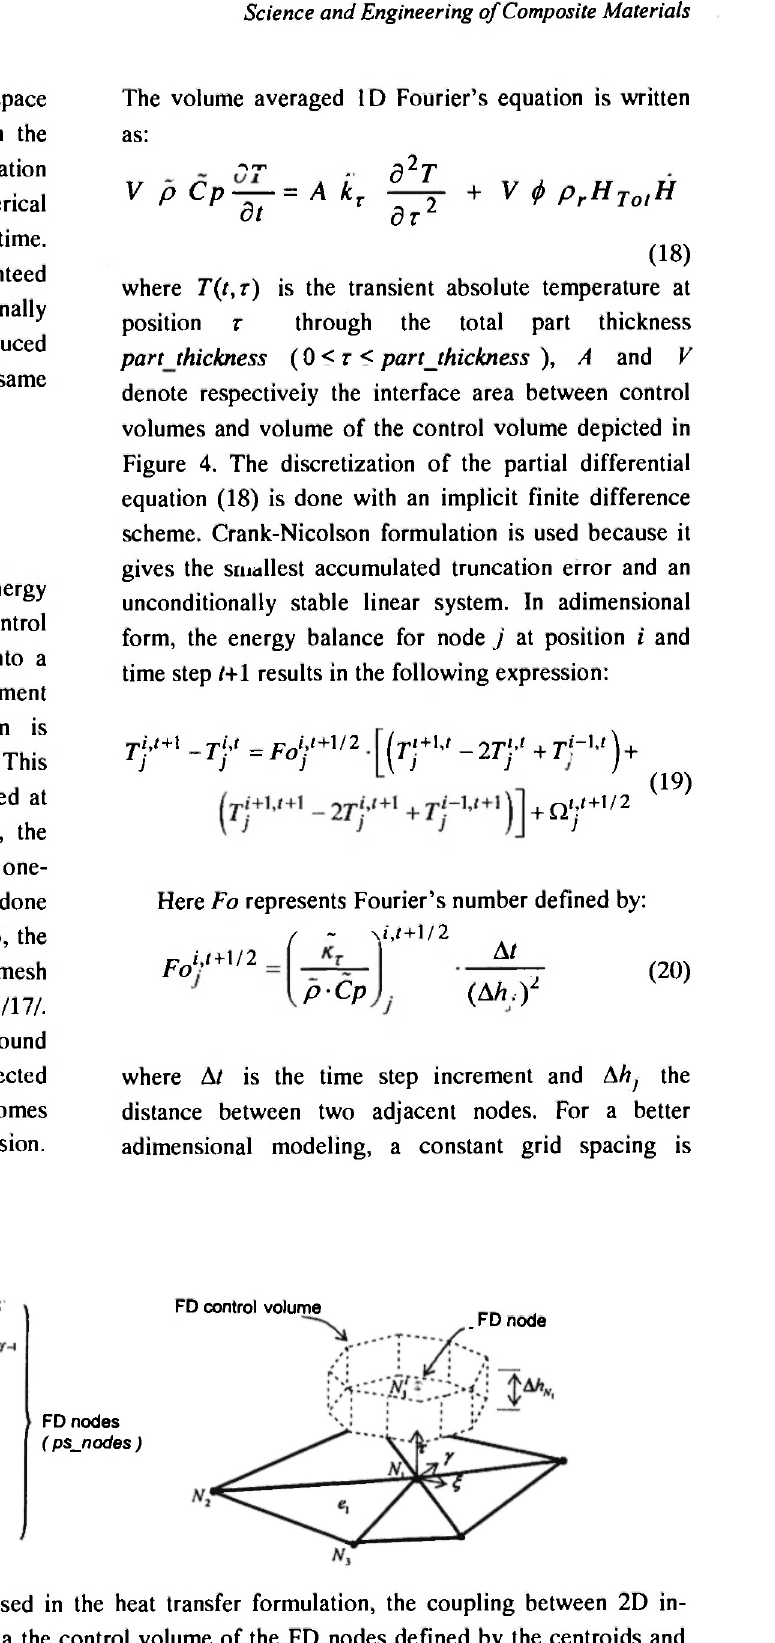
Because conforming finite elements are used in the heat transfer formulation, the coupling between 2D in- plane and 1D gapwise solutions is done via the control volume of the FD nodes defined by the centroids and mid-edges of connected